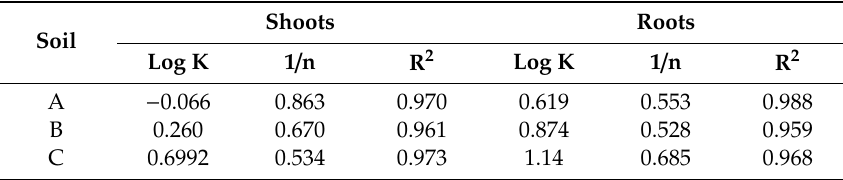
Table 5. Relationship between tungsten concentration in shoots and roots and tungsten concentration in soil solution. Parameters of the Freundlich-like model. Shoots Roots Soil Log K 1 / n R 2 Log K 1 / n R 2 A − 0.066 0.863 0.970 0.619 0.553 0.988 B 0.260 0.670 0.961 0.874 0.528 0.959